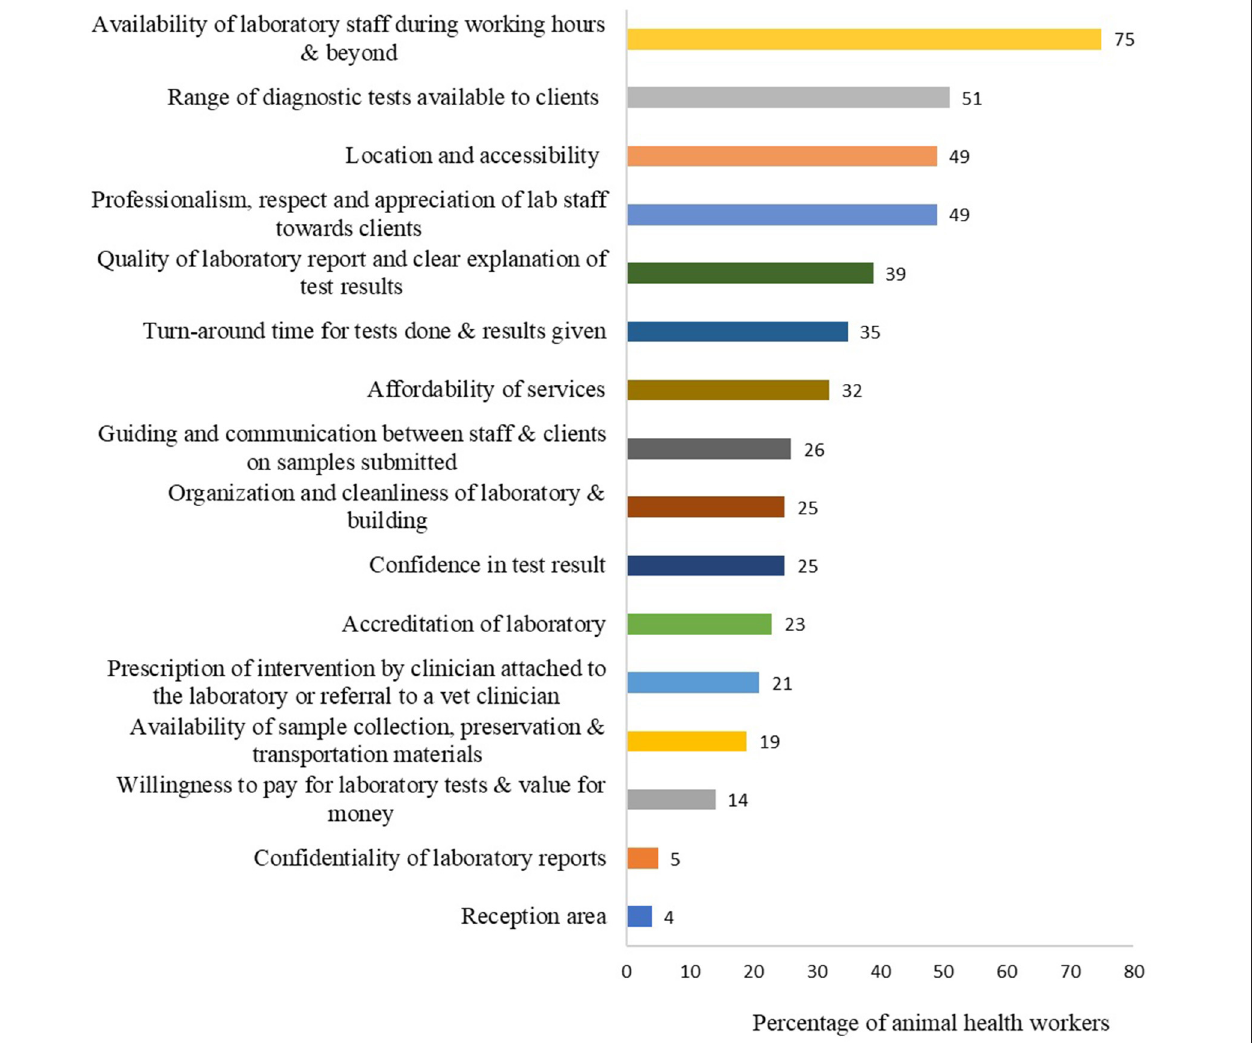
FIGURE 7 | Top ranked important factors that determine whether animal health workers would submit samples to a laboratory or not. Bars represent percent of animal health workers ( n = 57) that selected each factor. This question had multiple responses.